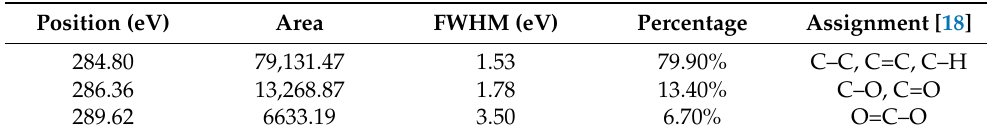
Table 3. Peak-fitting results of C 1s scan spectrum.